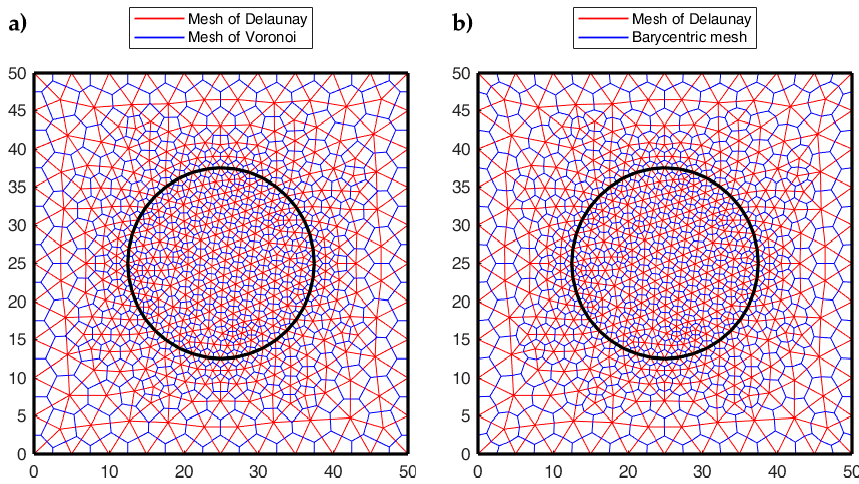
Figure 20. Generation of the second mesh, using ( a ) the circumcenters and ( b ) the barycenters.